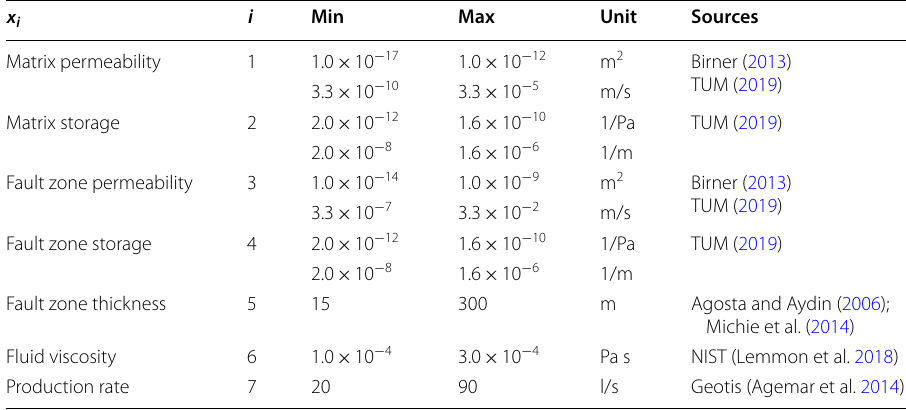
Table 1 Possible ranges for the hydraulic parameters of the Malm aquifer; unit conversions calculated for a fluid density of 971.82 kg/m 3 and a fluid viscosity of 2.89 10 − 4 Pa s (30 MPa pore pressure and 100 °C reservoir ×